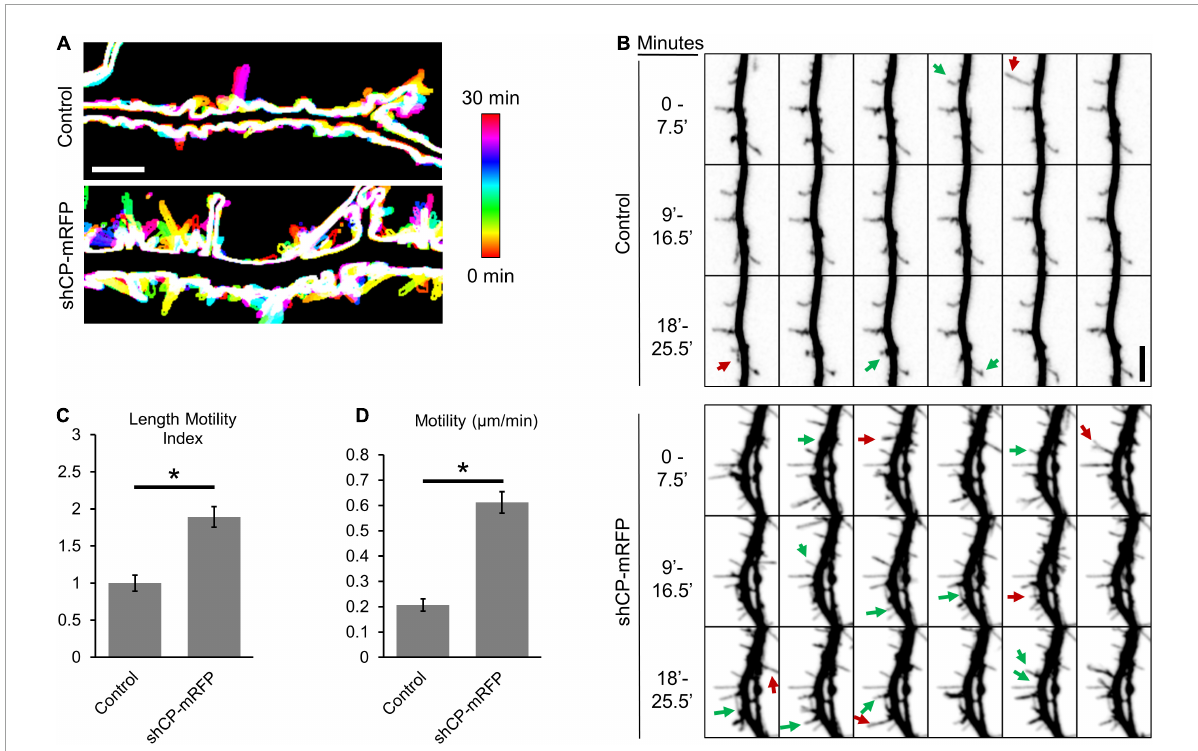
FIGURE1 Capping protein (CP) stabilizes dendritic protrusions. (A) Representative color-coded images show increased protrusion dynamics in CP knockdown neurons (co-expressing mRFP) compared to control neurons (mRFP). 30-min time-lapse recordings of protrusions were acquired from secondary or tertiary dendritic branches from DIV15 hippocampal neurons every 30 s. Maximum-intensity z-projections were created, thresholded to generate cell outlines, and temporally color-coded to allow visualization of protrusion dynamics. Scale bar, 5 µ m. (B) CP knockdown reduces the stability of dendritic protrusions. Montage of representative time-lapse video highlighting growing (green arrows) and retracting (red arrows) dendritic protrusions. 30-min time-lapse of DIV15 hippocampal neurons, transfected at DIV10 with either mRFP (Control) or shCP-mRFP. Quantification shows significantly increased rates of Length Motility Index (LMI) (C) and Motility (D) in CP knockdown neurons ( N = 5 neurons; 8–11 protrusions/neuron). Scale bar, 5 µ m. Error bars represent SEM. * P < 0.0001; Mann–Whitney